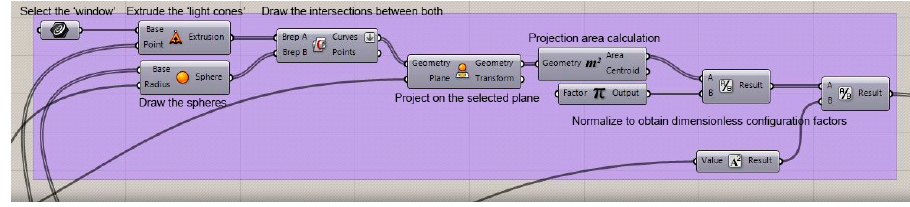
Figure 9. Algorithm to draw N × ( N − 1) spheres in the corner of the subdivisions.